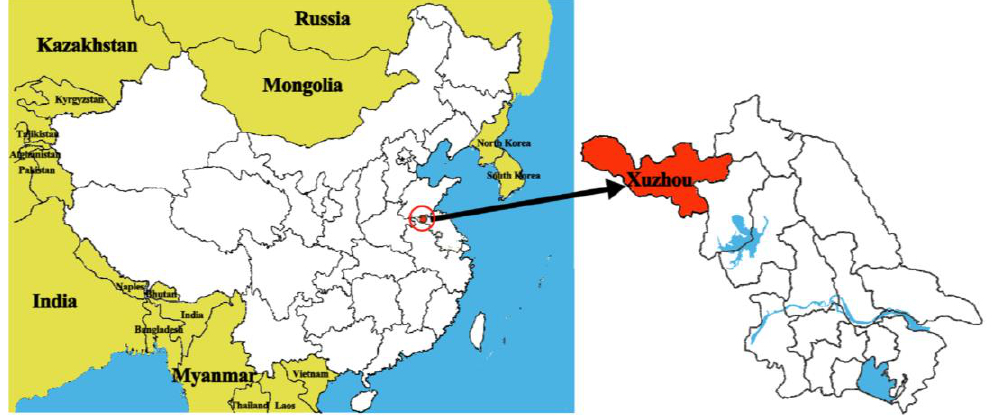
Figure 1. The location of Xuzhou.